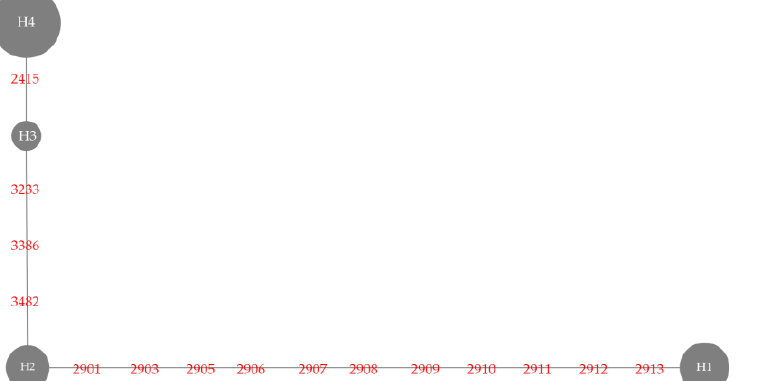
Figure 2. The haplotype network of the Badh2 gene. Letters inside the circle correspond to the haplotype name. The numbers on the lines indicate the position of nucleotide substitution polymorphisms. The size of each circle is proportional to the number of individuals varieties possessing that haplotype.